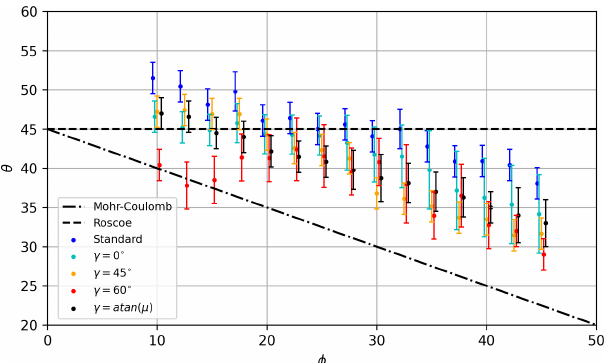
Figure 11. Sensitivity of the LKF orientation ( θ , degrees) to the Poisson ratio ( ν , unitless), in uniaxial loading experiments using different correction path angles ( γ ). The theoretical orientations from the Mohr–Coulomb and Roscoe theories are indicated by dashed–dotted and dashed lines, respectively, for